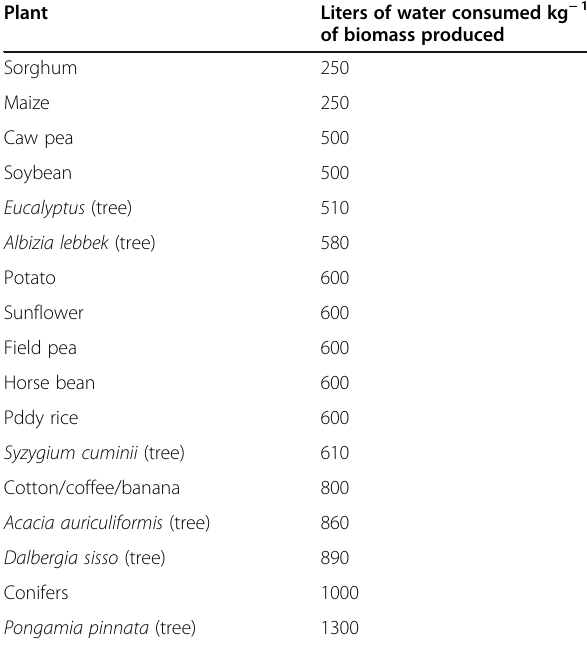
Table 1 Water use efficiency or consumption of water per unit of biomass produced (sources: [8,